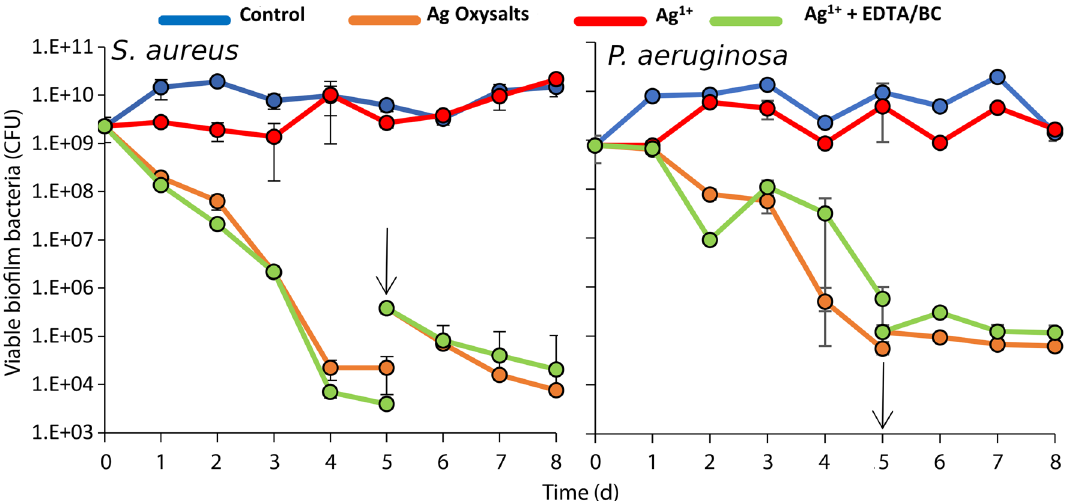
Figure 1. Quantification of viable bacteria in S. aureus and P. aeruginosa biofilms after treatment with silver dressings. S. aureus and P. aeruginosa colony biofilms were treated with silver dressings or a non-antimicrobial control dressing and remaining viable bacteria were quantified every 24 h. After 5 days biofilms were re-inoculated with 3.85 × 10 5 S. aureus or 1.22 × 10 5 P. aeruginosa colony forming units of planktonic bacteria respectively, to assess for biofilm reformation. Graph shows mean + /− standard